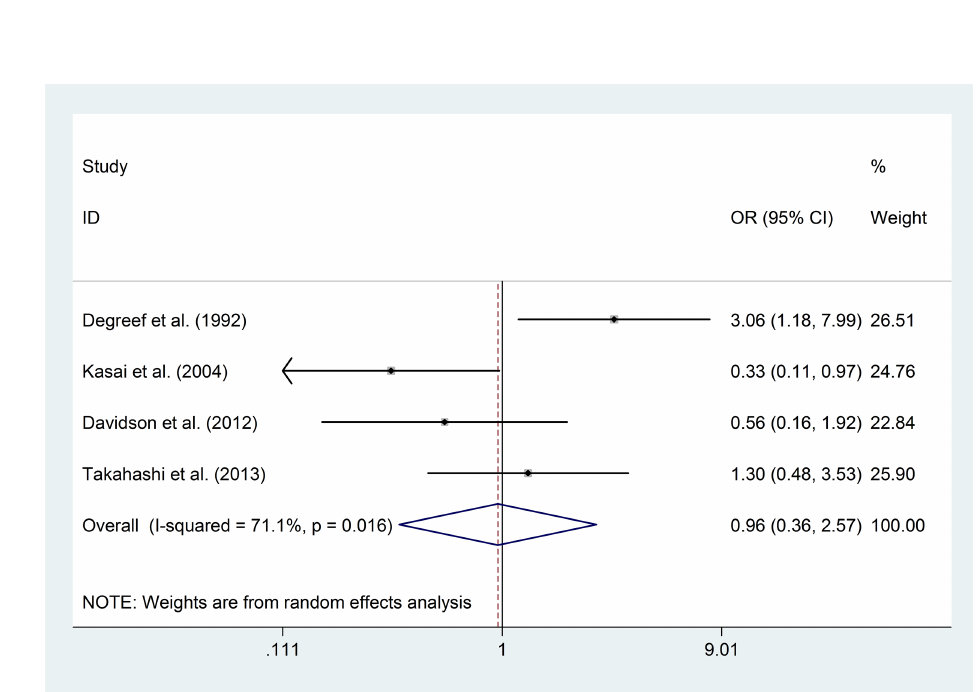
Fig 8. Prevalence of “any CSP” in FESZ patients and healthy controls.